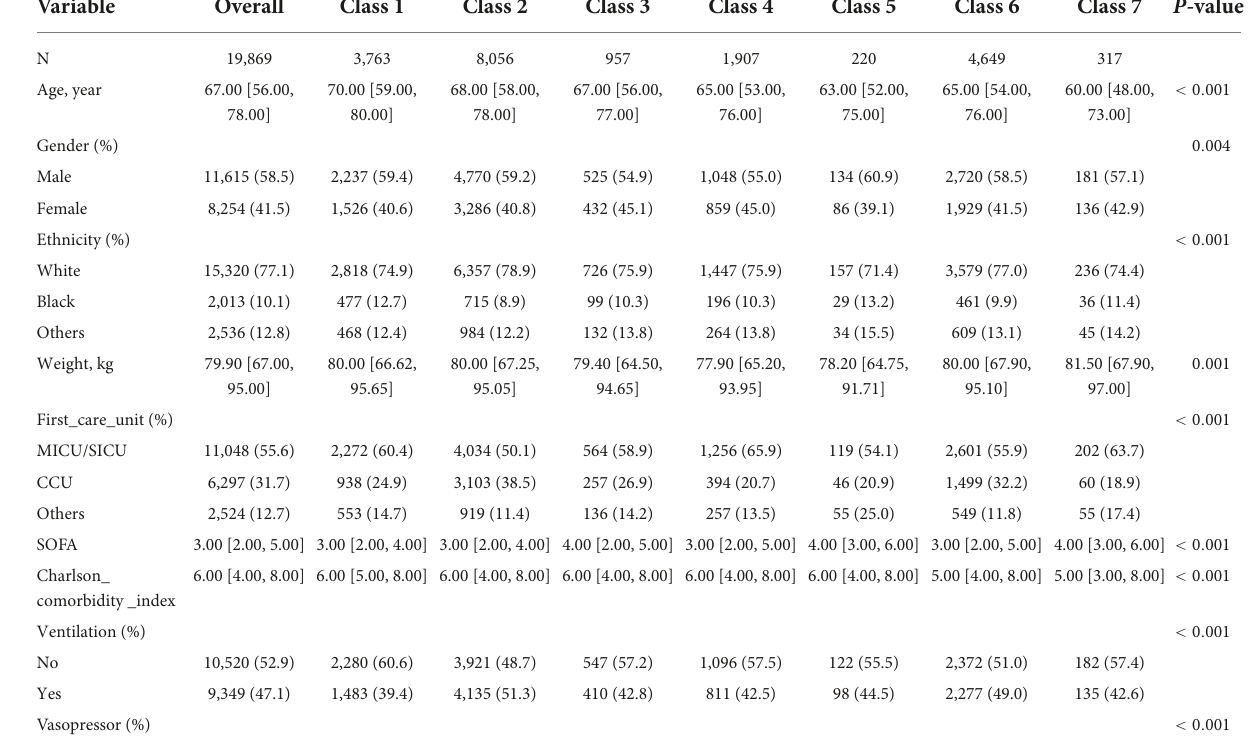
TABLE 1 Baseline characteristics of seven